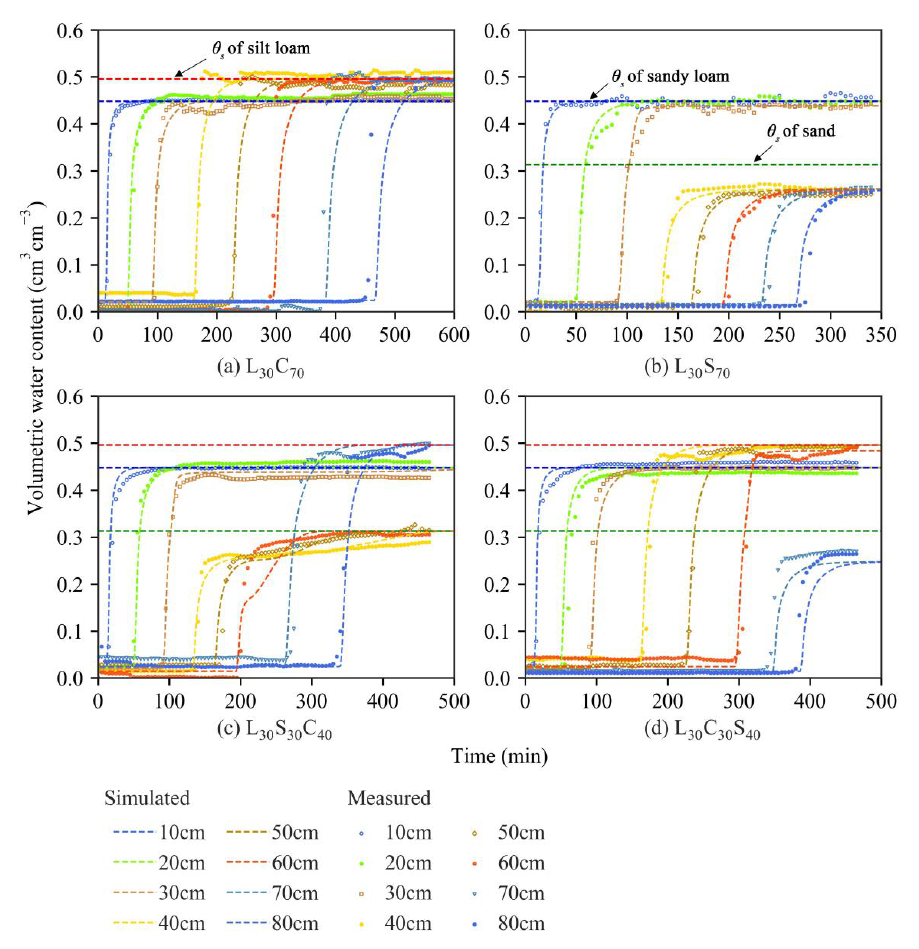
Figure 8. Measured and simulated water content at different depths in the infiltration process, (a) SL-SiL; (b) SL-S; (c) SL-S-SiL and (d) SL-SiL-S. ( b ) SL-S; ( c ) SL-S-SiL and ( d )